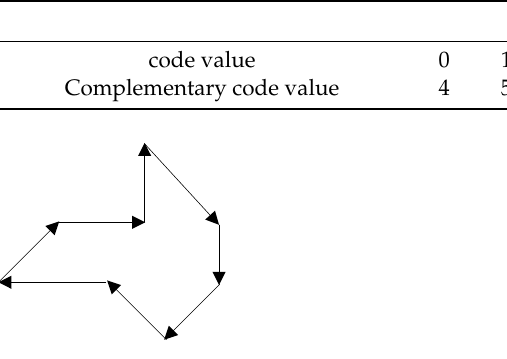
Figure 8. Eight-way chain code diagram (s is the starting point).